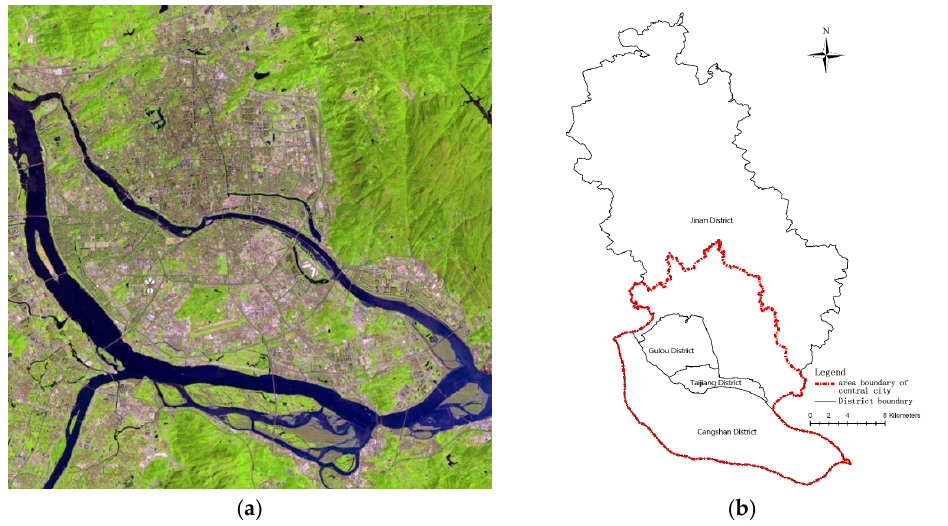
Figure 1. Remote sensing image of Fuzhou: ( a ) district scope of study; ( b ) scope of study. Fuzhou in southeastern China has 45 major parks and scenic areas, with a total area of 2149.21 hectares. There are 10 city-level comprehensive parks, 6 regional parks, 12 special parks, and 4 suburban parks distributed around the Beifeng and Gushan scenic areas [30]. There are still some problems in urban green space planning, though, and the construction of the urban green space system has not yet been perfected. At present, the green space construction in the central urban area of Fuzhou is still dominated by block green spaces, such as park and street green spaces, while the green space construction along the river system is still relatively backward. The afforestation status of the different administrative areas varies greatly. The Cangshan district has the best greening situation because its original vegetation is better and most of it is new urban area. In the old city district of Taijiang, on the other hand, the afforestation level is the lowest due to historical reasons. The main urban parks of Fuzhou are distributed in the Gulou District and Cangshan District, of which the West Lake Park, South Minjiang Park, and Jinshan Park are at